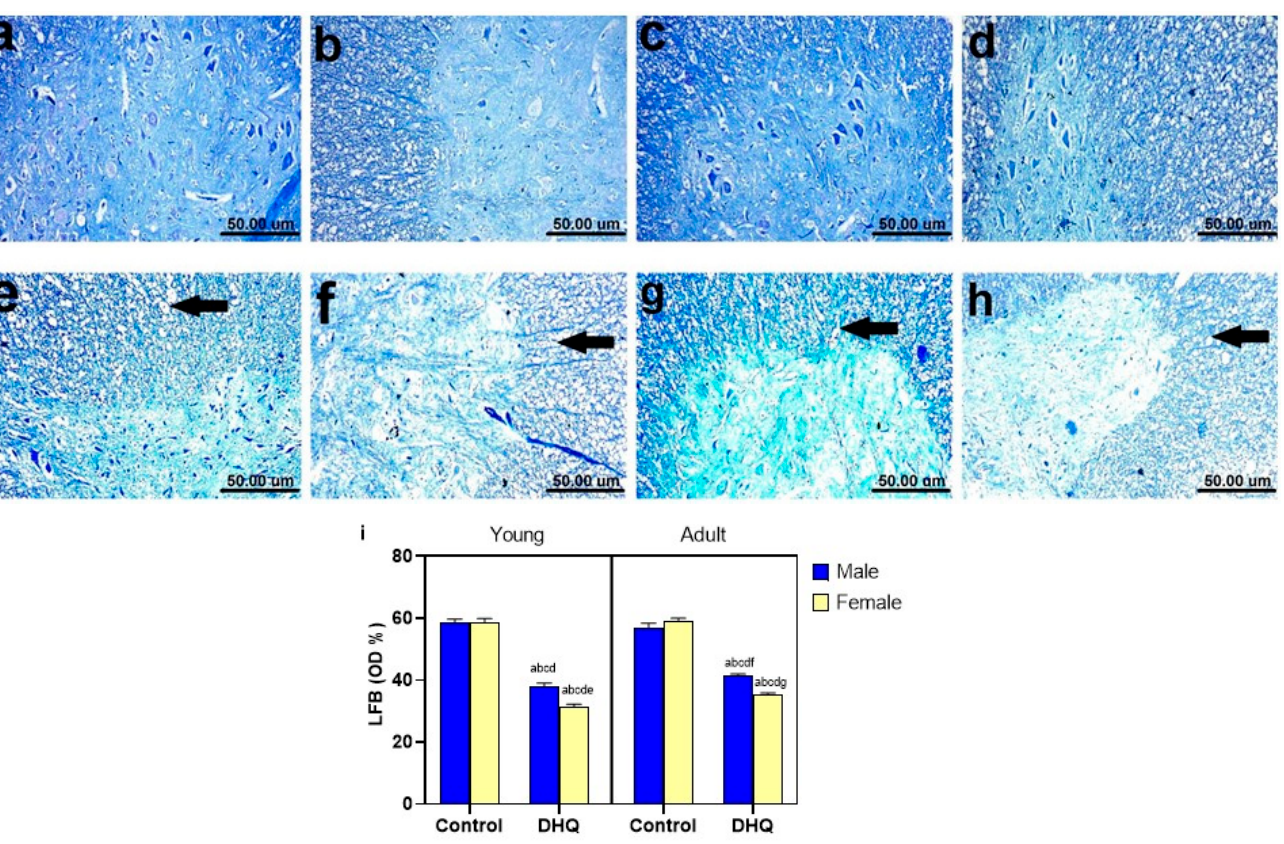
12 of 21 Figure 9. Histological Luxol fast blue-stained sections from striatum of ( a – d ) control rats, ( a ) young male, ( b ) young female, ( c ) adult male, and ( d ) adult female, showing apparently normal dark blue